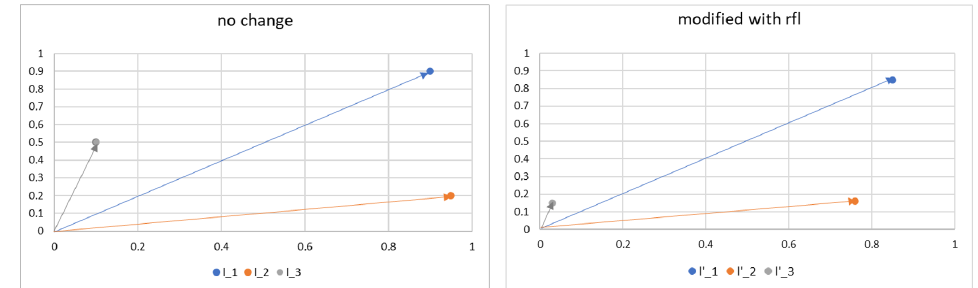
Figure 2. Geometric interpretation.